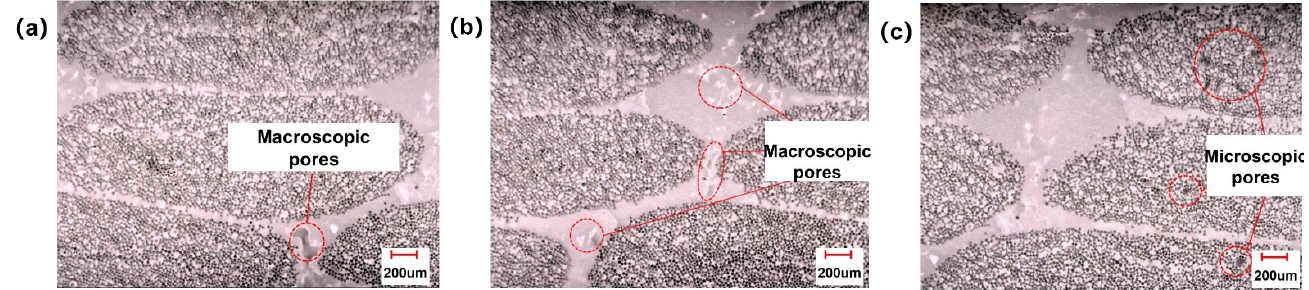
Figure 14. Microscopic morphology of pore distribution under different capillary numbers: ( a ) 0.007; ( b ) 0.018; ( c ) 0.037.